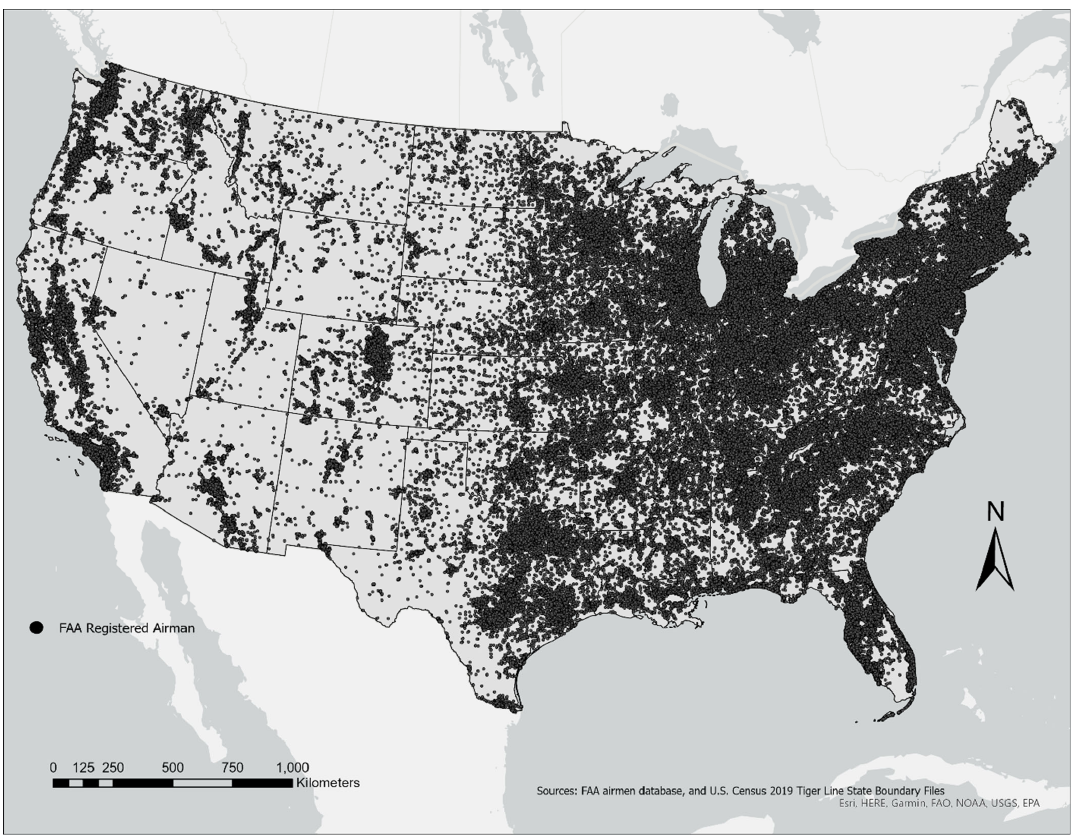
Figure 1. Geocoded point locations for FAA Registered Airmen within the continental U.S.